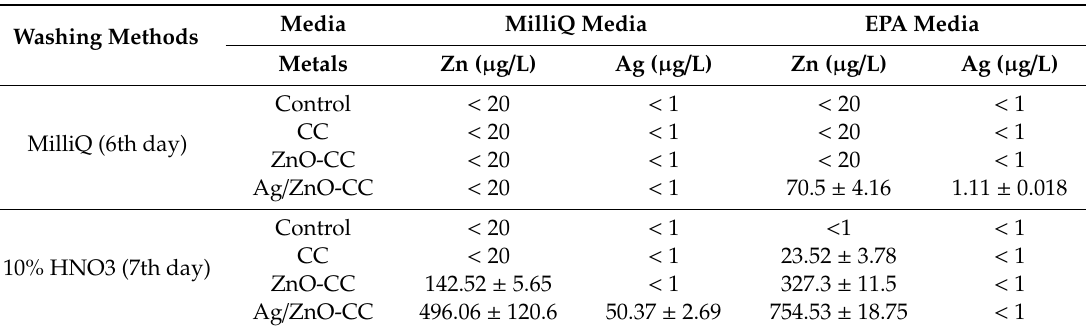
Table 2. Metals in washing water used to clean the experimental set up. Washing was carried out with MilliQ water and 10% HNO 3 after the termination of the 5-days’ release. Average concentrations in washing water and standard deviations (n =